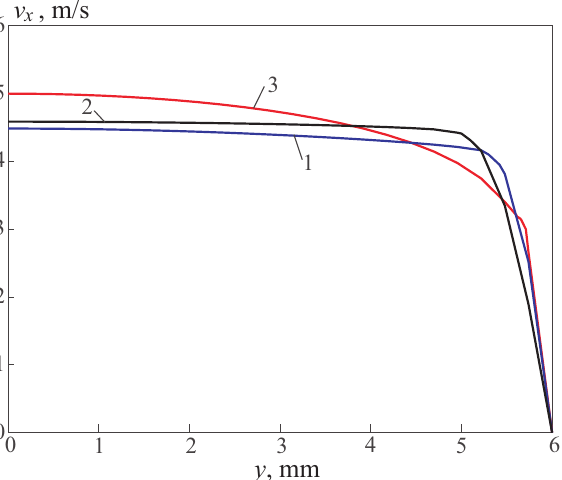
Figure 10. Radial distributions of oil axial velocity in different pipeline cross sections at x = 0.5 m (line 1), x = 1.5 m (line 2), and in the exit section (line 3). Fluid enters the tube with a uniform velocity. When the fluid contacts the surface, viscous effects become important, and a boundary layer develops with an increasing axial coordinate. This development occurs at the expense of a shrinking inviscid flow region and concludes with the boundary layer merger at the centreline (hydrodynamic entry